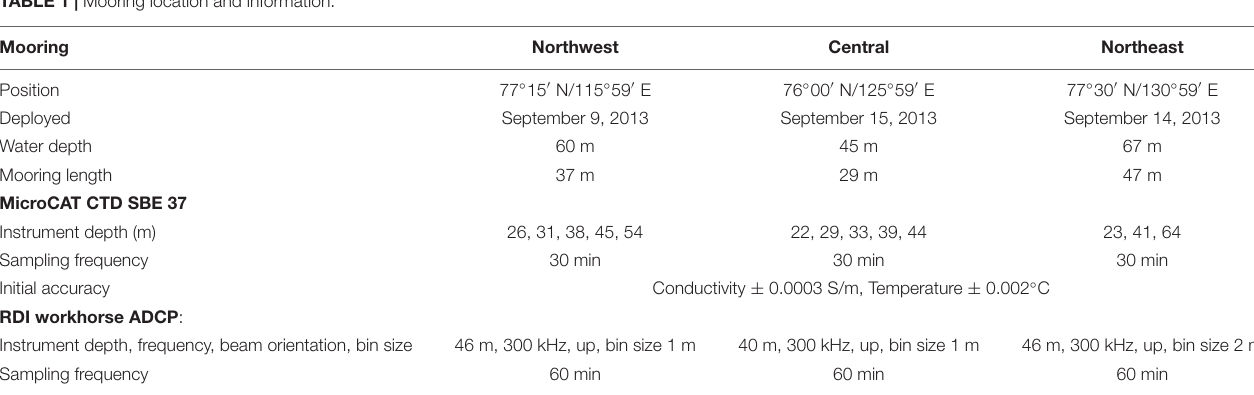
FIGURE 4 | 2013 (red) and 2014 (blue) cruise tracks. Green stars indicate mooring locations. TABLE 1 | Mooring location and